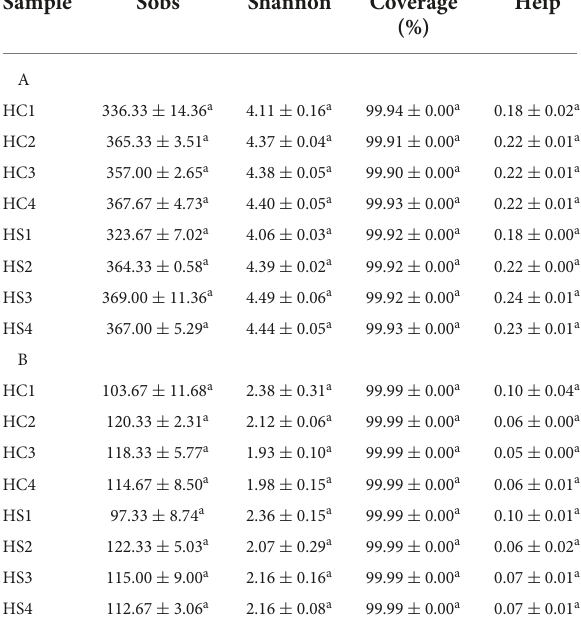
TABLE 1 Alpha diversity analysis (A, bacteria; B, fungi) of two treatment